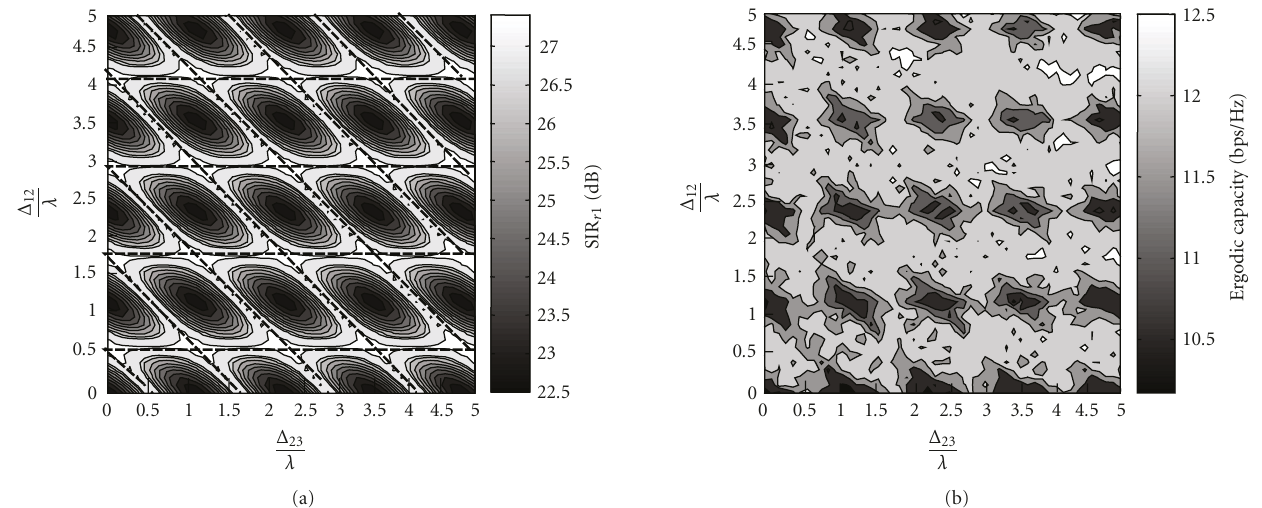
Figure 5: Setting-A: rank-1 approximation (a) of the signal-to-interference ratio, SIR r 1 ( Δ , η ), versus Δ 12 /λ and Δ 23 /λ . Dashed lines denote the optimality conditions (24) obtained by the rank-1 approximation. As a reference, ergodic capacity is shown (b), for an angular spread approaching